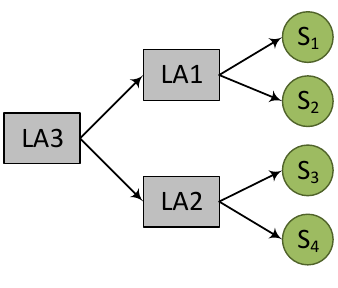
Figure 2. HSLA as a VNF